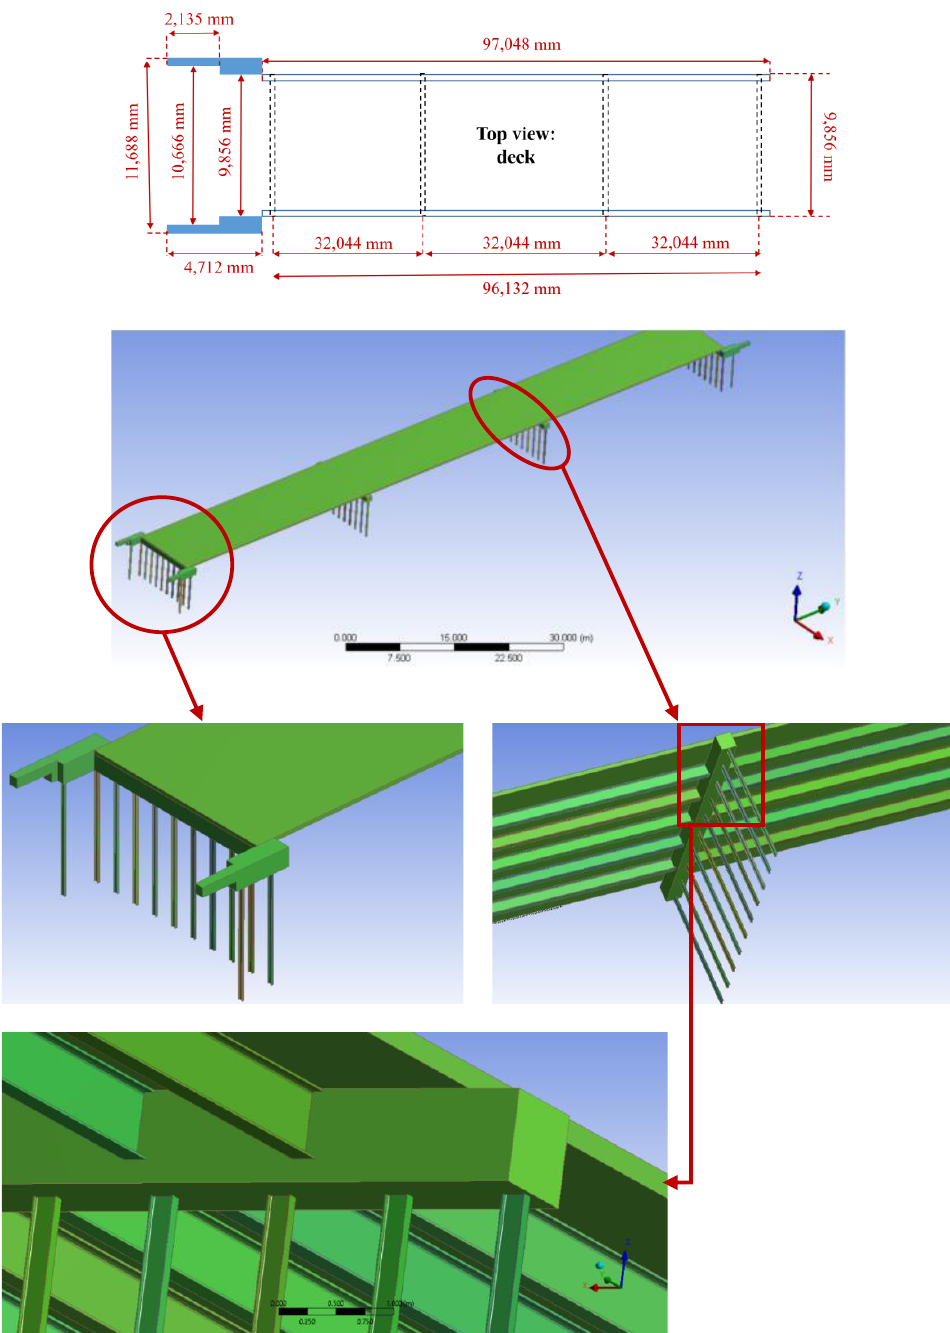
Figure 1. Details of the real-scale geometric model of an integrated concrete bridge with H-shaped steel piles.